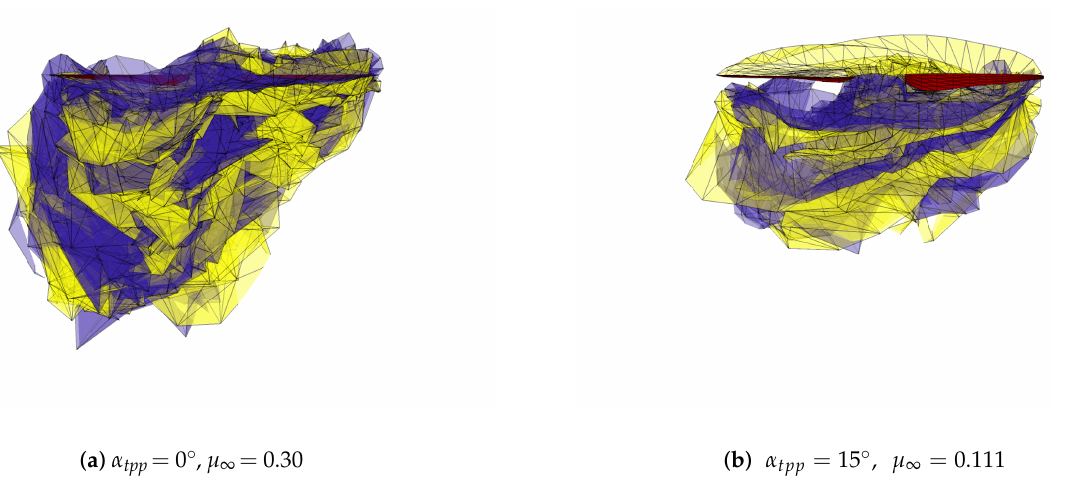
Figure 17. Frontal view of a T-MOTOR 18x6.1 and wake as modeled in the DDE